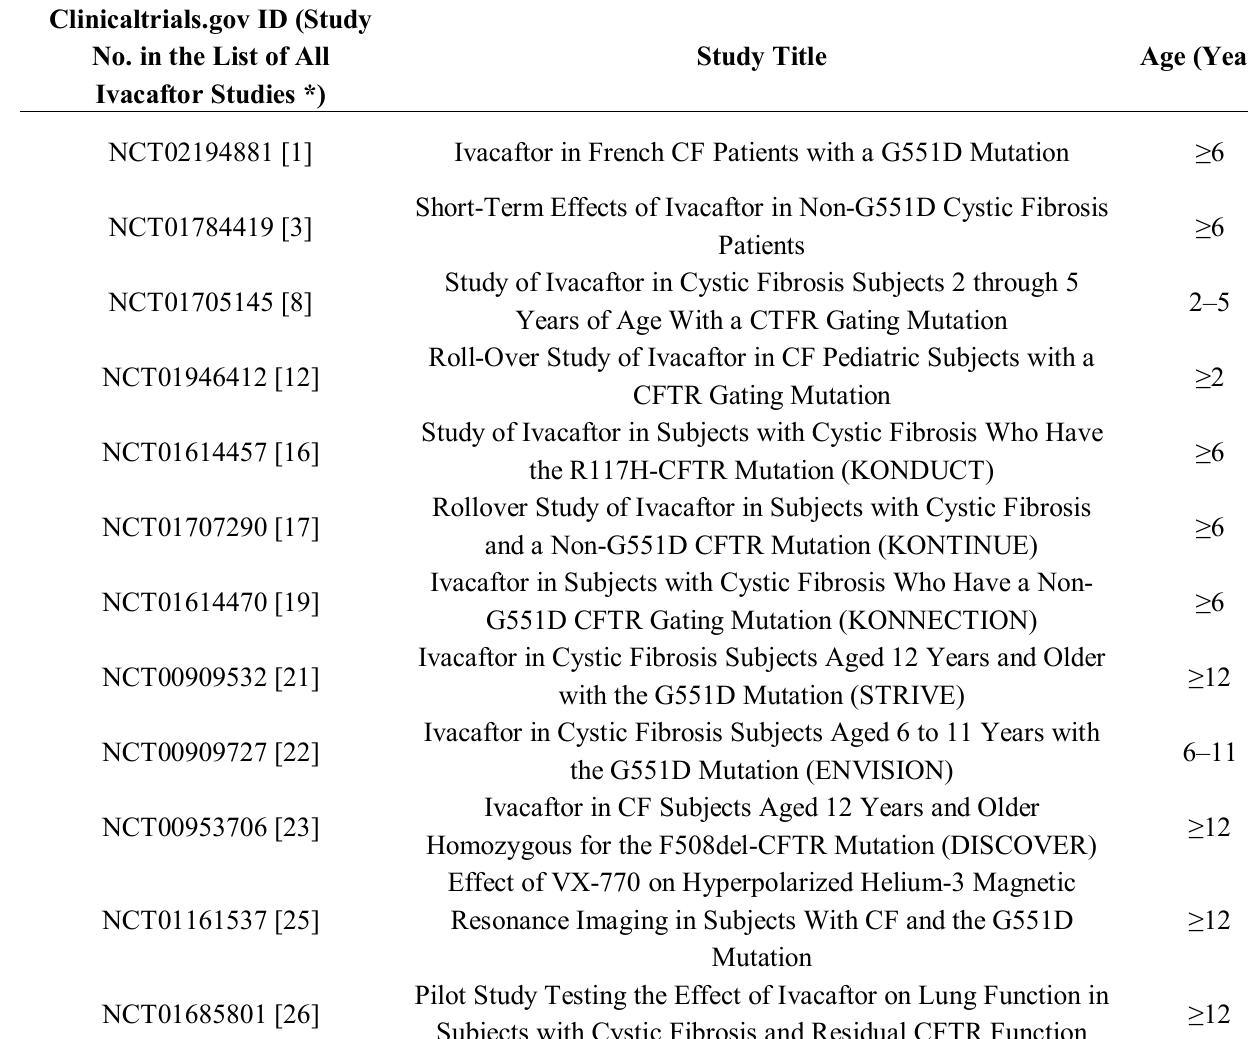
Table 3. Ivacaftor studies on